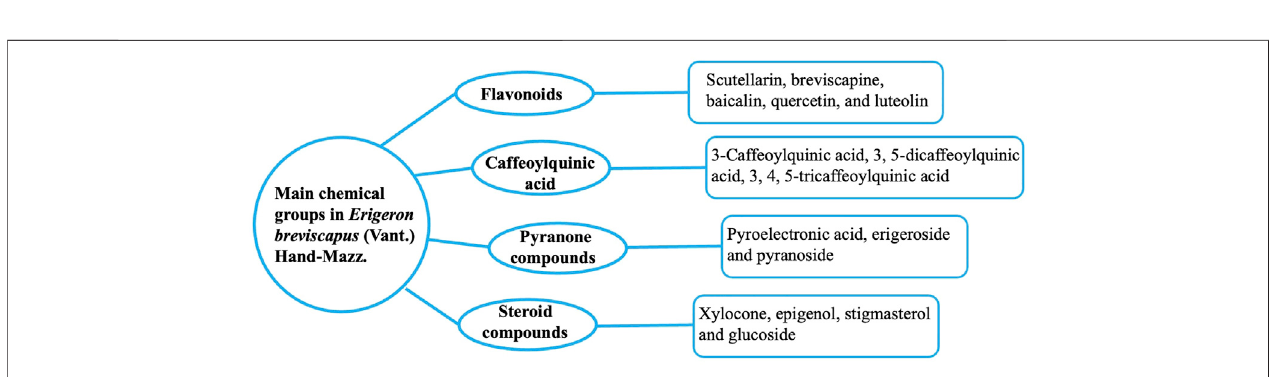
FIGURE 2 | Main chemical classes present in Erigeron breviscapus (Vant.) Hand-Mazz.